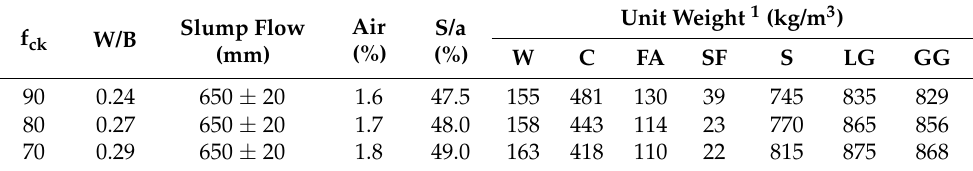
Table 2. Mix proportion.